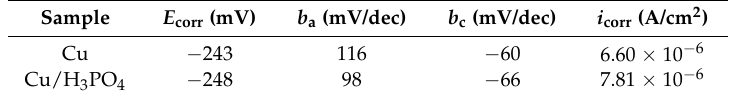
Figure 6. Potentiodynamic polarization curves of copper electrode with or without H 3 PO 4 solution treatment. Table 2. Polarization parameters of copper electrode with and without H 3 PO 4 solution treatment.